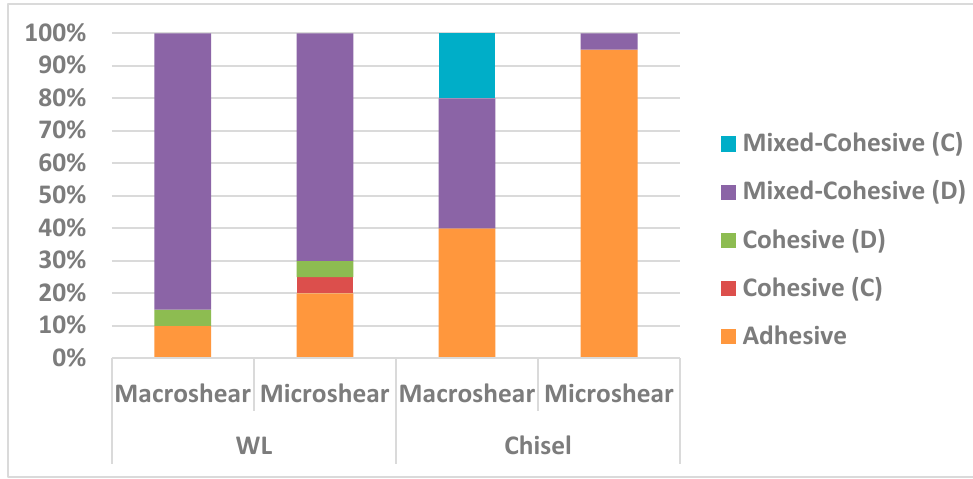
Figure 4. Stacked bar chart showing the failure mode percentage strength for different tested groups. Table 2. Frequency and percentage for different tested groups.